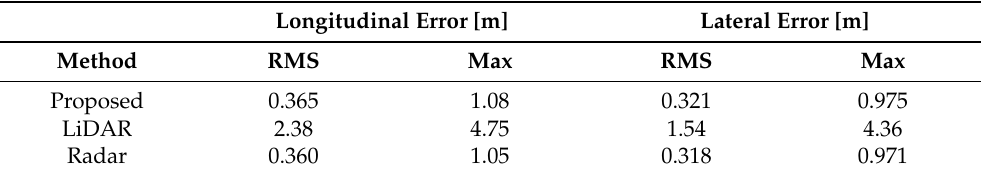
Table 5. RMS and max errors on snow-covered road surface condition.